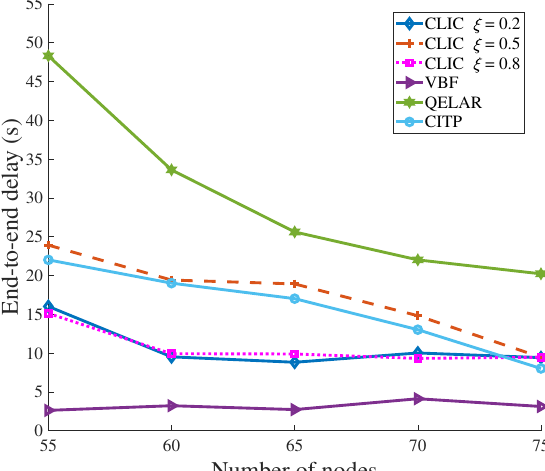
Figure 9. Comparison of end-to-end delay versus the number of nodes.